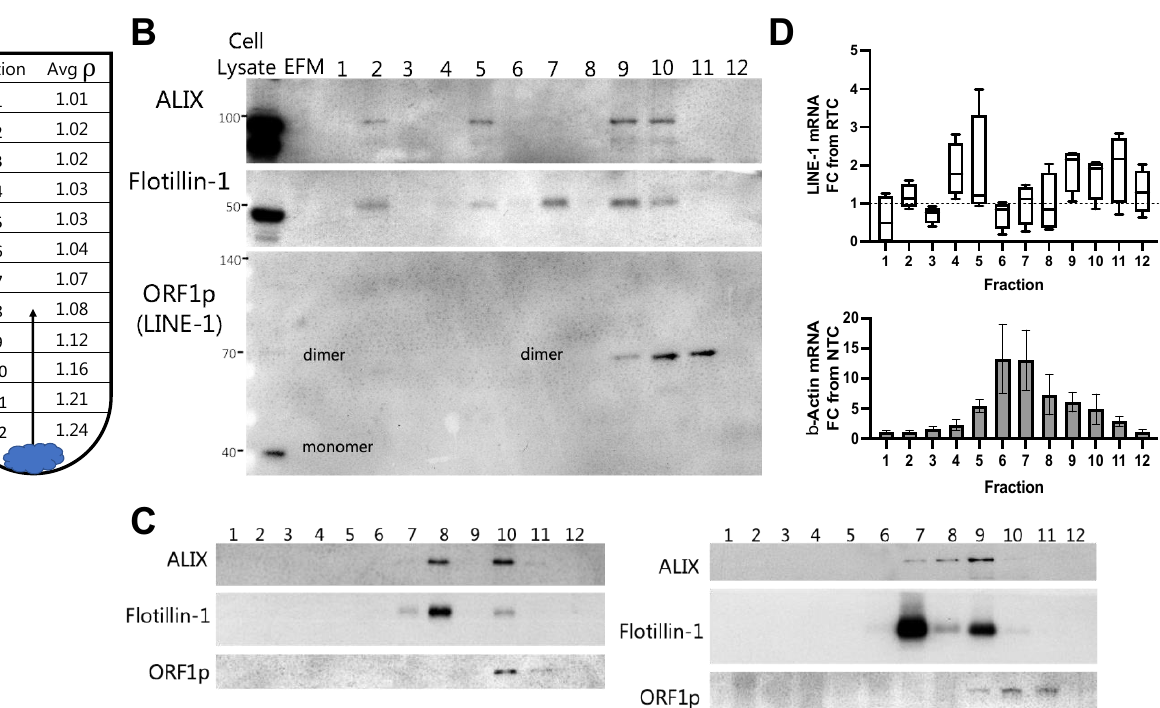
Figure 2. Buoyant density gradient ultracentrifugation demonstrates the presence of Long Inter- spersed Element-1(LINE-1) mRNA and ORF1p in high- and low-density extracellular vesicles (EVs). EVs from H460 cells stimulated with 1 µ M BaP were subjected to iodixanol buoyant density gradient ultracentrifugation to examine the presence of LINE-1 mRNA and protein within EVs and their distribution across EV populations. ( A ) Mean densities of 1 mL fractions from three gradient preparations. Diagram showing how EVs rise to the gradient level equivalent to their density during the course of centrifugation. ( B ) Western blot of EV proteins present in density gradient fractions 1 – 12. ALIX and Flotillin-1 are proteins enriched in EVs. ORF1p, which often appears in multimers in SDS-PAGE, is visible as a putative dimer within EVs. Cell lysate is shown as a positive control, EV-free media (EFM) as a negative control. ( C ) Western blots from two additional independent gradients. ( D ) mRNA in gradient fractions. mRNA was quantified by One-Step RT-qPCR. Amplicons were expressed as fold-change from the Reverse Transcriptase Control (LINE-1, top) or Non-Template Control ( β -Actin, bottom). For LINE-1, the minimum, maximum, and mean are shown in box plot. β -Actin, mean and SEM shown. N = 3 – 4.